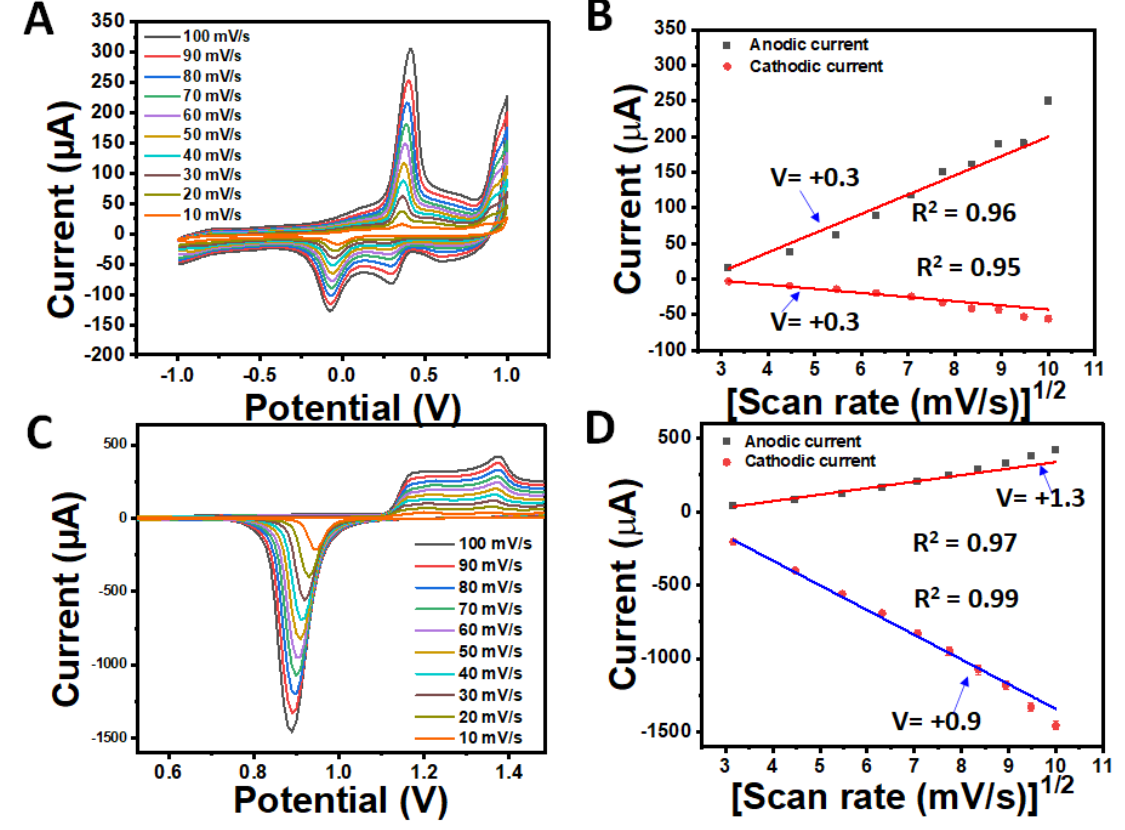
Figure 4. ( A ) Scan-rate-dependent experiment of GCE/AuCoCu-imprinted surface in 0.1 M Na 2 SO 4 with the scan rate ranging from 10–100 mV/s; ( B ) Corresponding curve showing linearity, with a correlation coefficient of 0.96; ( C ) Scan-rate dependent experiment of the GCE/AuCoCu surface in 0.5 M H 2 SO 4 with the scan rate ranging from 10 – 100 mV/s; ( D ) Corresponding current showing linearity, with a correlation coefficient of 0.97.